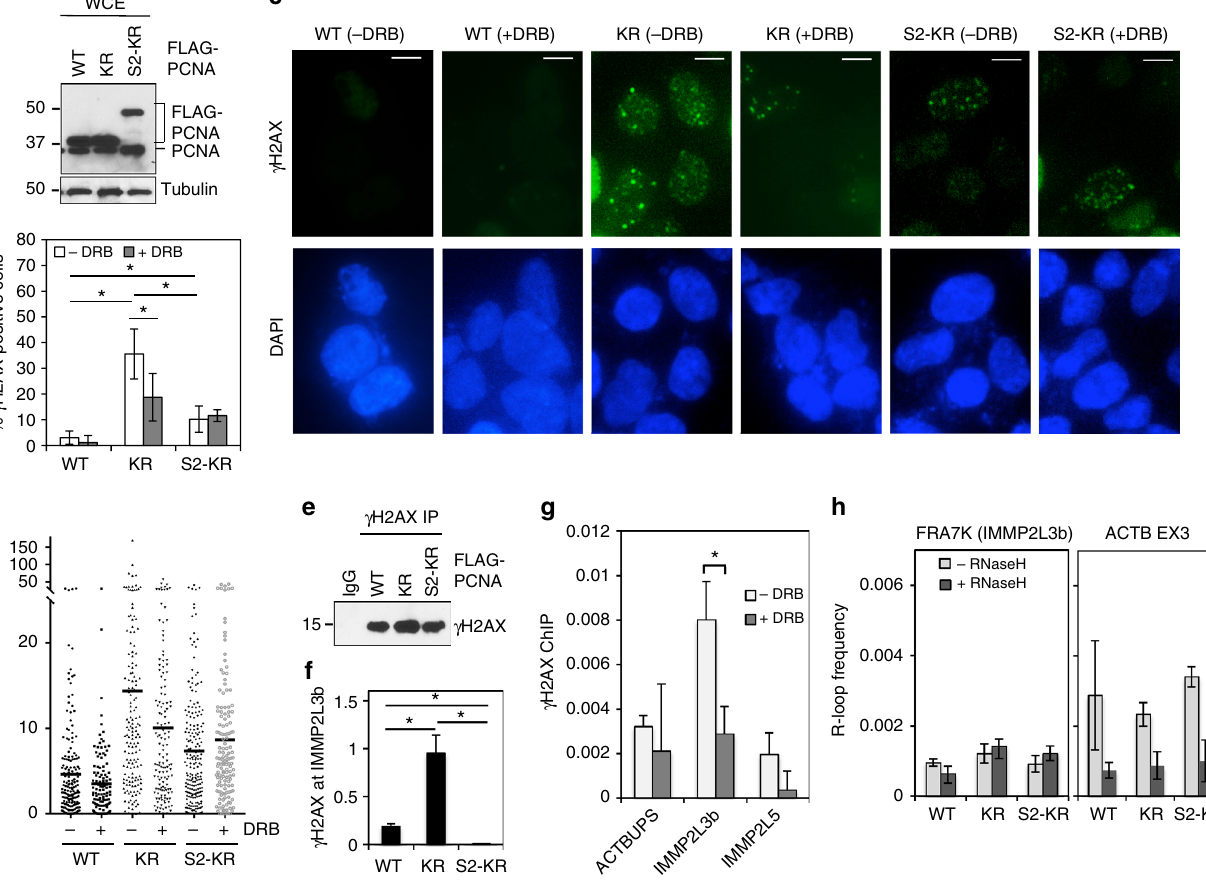
Fig. 6 SUMO2-PCNA suppresses transcription-induced DSBs. a Western blot analysis of PCNA and FLAG-PCNA in whole cell extracts (WCE) using an antibody against PCNA. Tubulin was used as a loading control. b Quanti fi cation of γ H2AX-positive cells overexpressing the indicated FLAG-PCNA complexes with or without DRB treatment (100 µ M). Each value in the graph represents the average value ± standard deviation ( n > 200) per one representative experiment. Only cells with 5 or more γ H2AX foci were counted as positive cells. The result was reproduced in two independent assays. c Representative fl uorescence images of γ H2AX foci (green) in HEK293T cells overexpressing the indicated FLAG-PCNA proteins with or without DRB treatment. Nuclei were counterstained with DAPI. Scale bar, 10 µ m. d The average tail moments (horizontal lines) measured by the neutral comet assay using HEK293T cells overexpressing the indicated FLAG-PCNA constructs with or without DRB treatment. Each dot represents the tail moment of a single cell. At least 150 cells were analyzed per one representative experiment. The result was reproduced in three independent comet assays. e Western blot analysis of immunopuri fi ed γ H2AX from formaldehyde-treated HEK293T cells for ChIP analysis. f ChIP analysis of the samples from e for γ H2AX occupancy at FRA7K using IMMP2L3b primers. The result was reproduced in two independent assays. g ChIP analysis of γ H2AX occupancy at indicated loci in HEK293T cells overexpressing FLAG-PCNA (KR) and treated with or without DRB. The result was reproduced in three independent assays. h Representative analysis of R-loop frequency at IMMP2L3b (left) and ACTB exon 3 (EX3; right) sites in HEK293T cells overexpressing the indicated FLAG- PCNA constructs. The isolated nucleic acids were treated with or without RNase H prior to R-loop immunoprecipitation. The result was reproduced in two independent assays. For all the ChIP experiments described above, each value represents the average value±standard deviation calculated from triplicate qPCR reactions per one representative experiment. p values were calculated using t -test analysis for statistically signi fi cant differences. p ≤ 0.05 are indicated with an asterisk